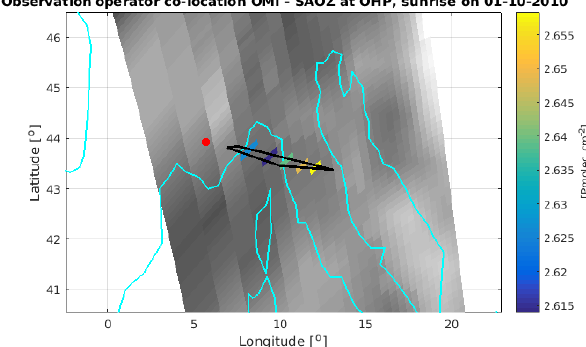
Figure 2. Illustration of a single co-location between OMI and a sunrise ZSL-DOAS measurement using the dedicated observation operator. The red dot marks the location of the ground instrument, the cyan lines indicate the coastlines of this part of the Mediter- ranean, the greyscale background contains the full orbit data and the coloured pixels are those that have their centre within the ob- servation operator (black polygon), i.e. those that are averaged to obtain a satellite measurement comparable with that of the ZSL- DOAS